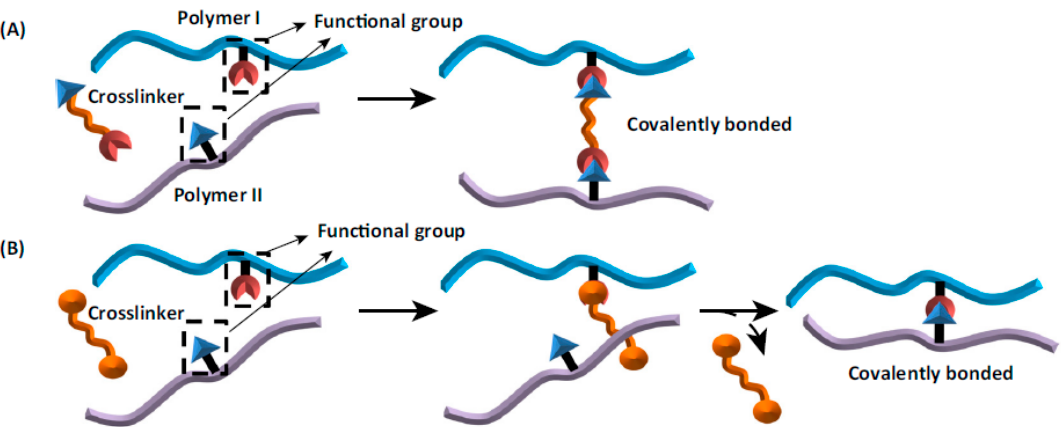
Figure 5. Chemical crosslinking may occur by a reaction between functional groups of polymer(s) and a crosslinking agent which acts as a covalent link between the chains ( A ) or the reaction between the polymer chains and a crosslinker which acts to connect the chains but is disposed of after the reaction ( B ) Reprinted with permission from [24]. Copyright 2022, Elsevier.